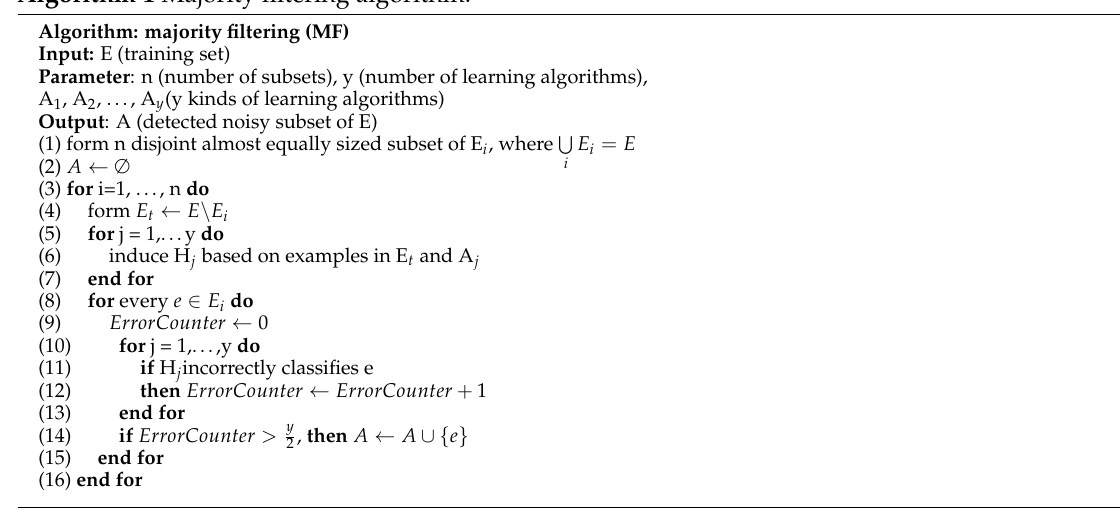
Algorithm 1 Majority filtering algorithm.